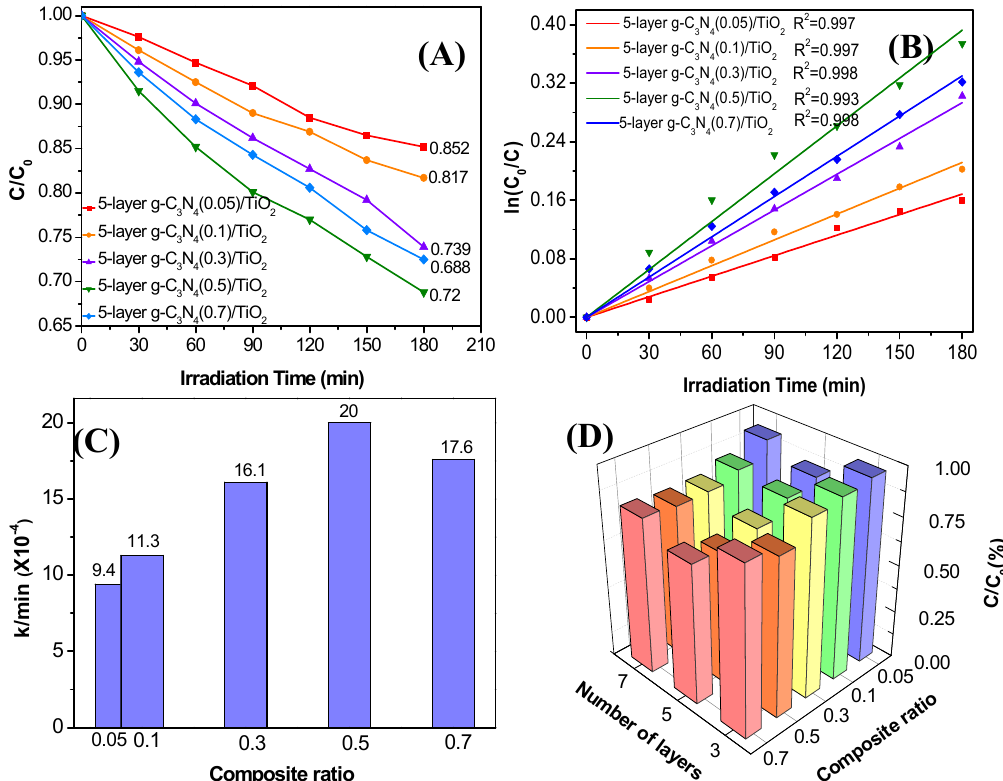
Figure 6. ( A ) Photocatalytic degradation of Rh B by g-C 3 N 4 /TiO 2 thin films with a different ratio. ( B ) The first-order kinetic fitting curve of photocatalytic degradation. ( C ) The histogram of reaction constants k for Rh B degradation by g-C 3 N 4 /TiO 2 thin films with different composition ratios under visible light. ( D ) The histogram of the three-dimensional degradation rate for all the prepared photocatalysts with different thicknesses and composition ratios.